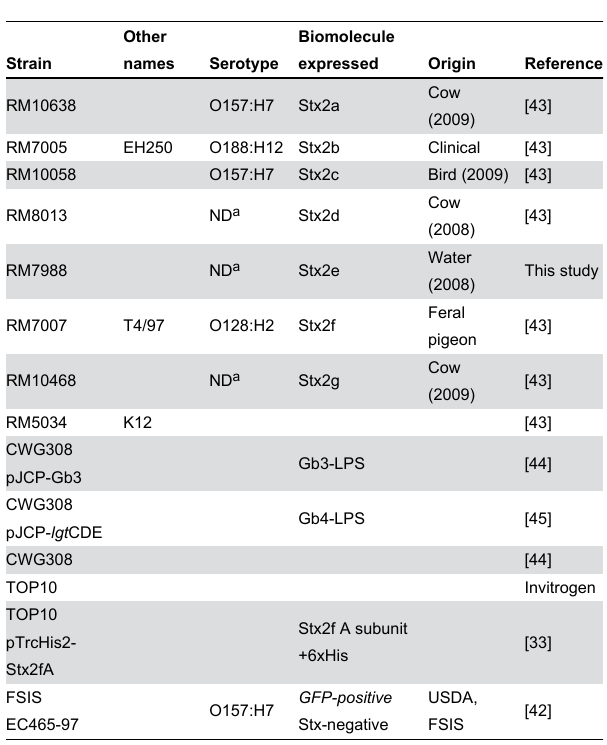
Table 1. E. coli strains used in this